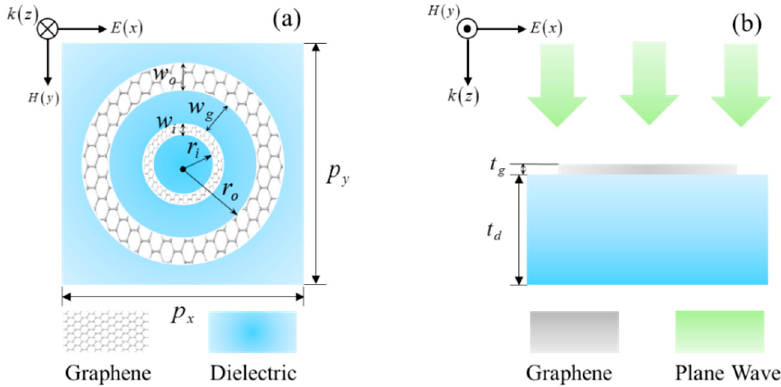
Figure 1. Schematic of the geometry of the proposed monolayer graphene-based concentric-double- rings (CDR) structure. ( a ) The top view of the unit cell: the periodic graphene nanostructure arrays with radius of inner-ring r i = 90 nm, width w i = 10 nm, radius of outer-ring r o = 148 nm, width w o = 30